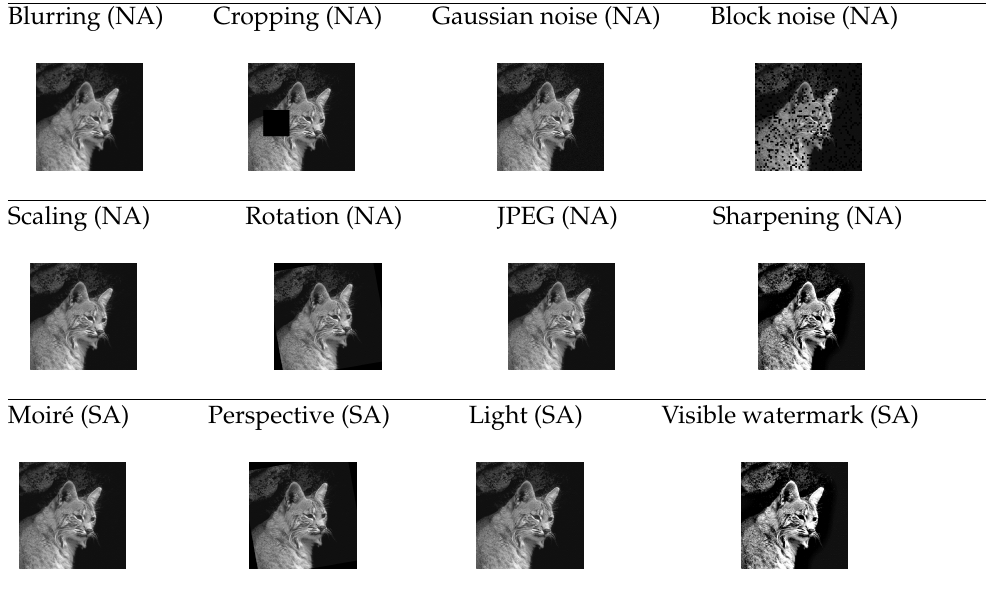
Figure 12. Simulating image distortions for screen-shooting.